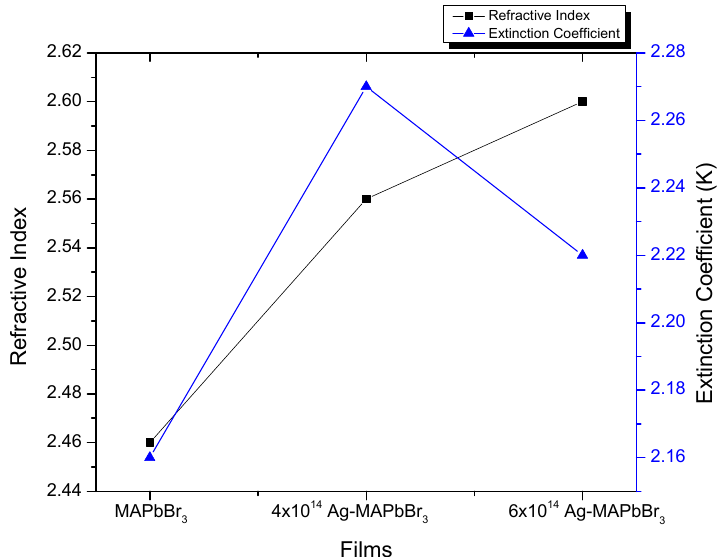
Figure 7. Refractive index and extinction coefficient of pure MAPbBr 3 and Ag-implanted MAPbBr 3 films.